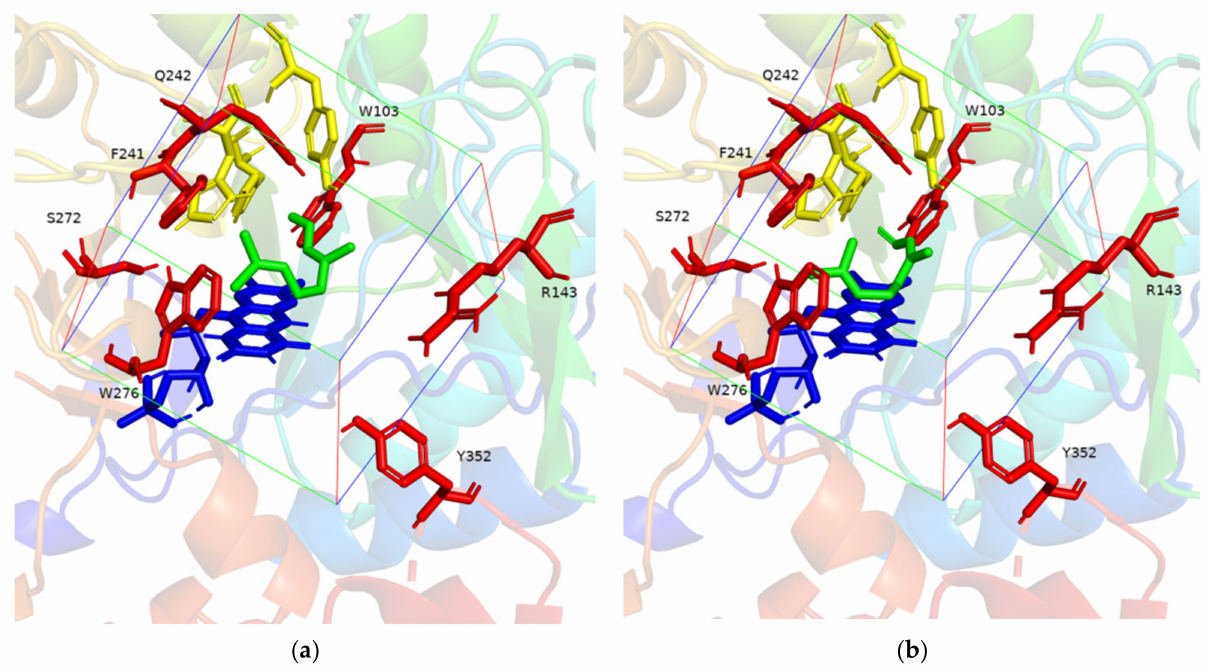
Figure 1. Identification of putative hot spots through molecular docking of NemR-PS and the ligand ( Z )-citral ( a ) or ( E )-citral ( b ). The box in the figure represents the 5 Å vicinity of the docked ligand as the center. Green, ligand; blue, cofactor FMN, yellow, active sites; red, putative hot